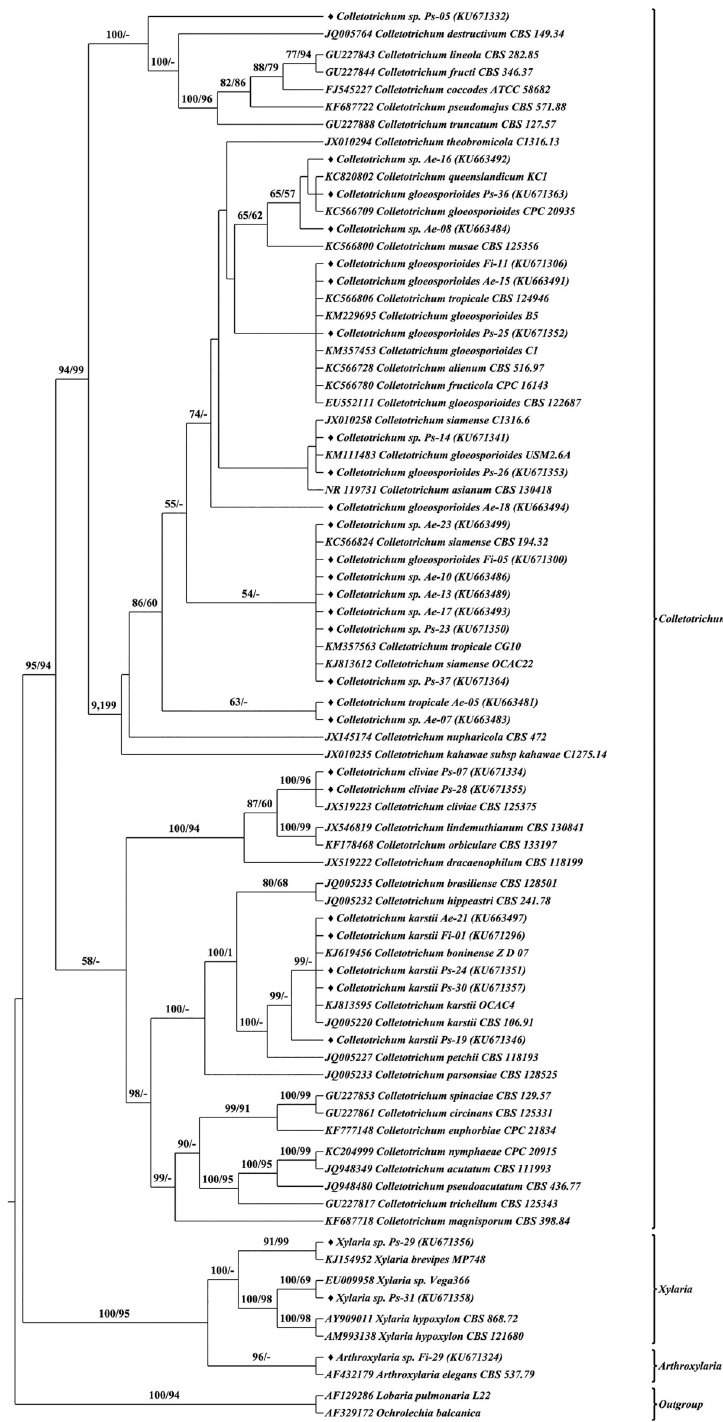
Fig 9. Internal transcribed spacer 2 sequence–secondary structure based phylogenetic tree of Glomerellales and Xylariales query and reference sequences. The query sequences are represented by the symbol “ ♦ ”. Bootstrap (BP) values � 50 were represented in the tree. Maximum Likelihood tree was presented with branch support values as BP of ML tree / BP of NJ tree.